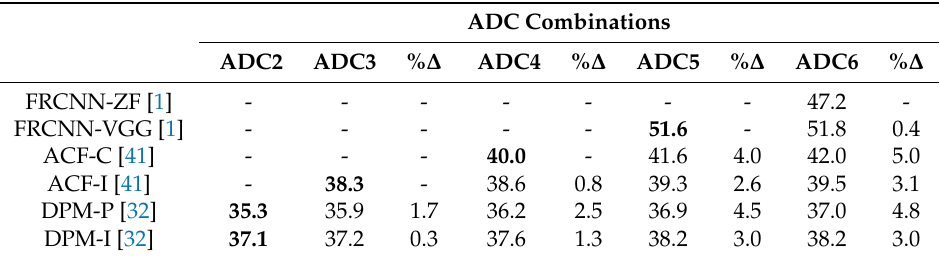
Table 4. Average FScore of the five ADC combinations from ADC2 to ADC6. Percentage increase (% ∆ ) calculated for each detector with respect to the previously obtained performance just before the additional detector inclusion in the combination (in bold), from ADC2 to ADC5, respectively. Data adapted from [15]. ADC